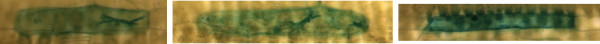
Typical examples of transformed cells. Both the left and the centered cell contain one haustorium of the powdery mildew fungus.